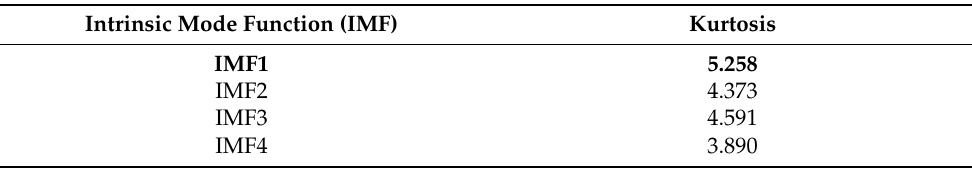
Table 1. The kurtosis of the first four IMFs (Simulation).